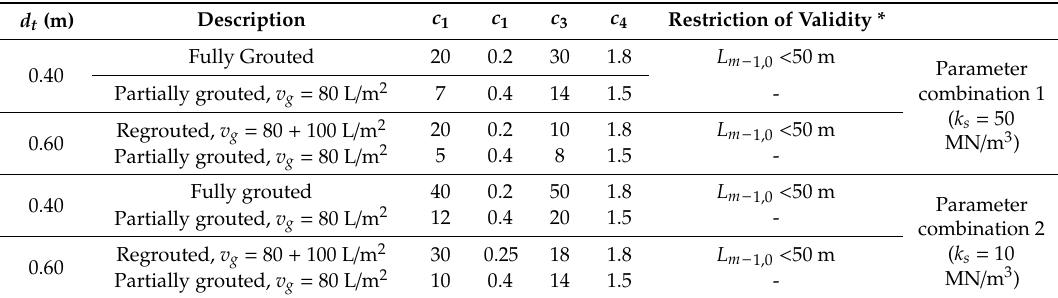
Table 7. Empirical coe ffi cients of the enveloping functions of the maximum relative bending stress for each parameter combination and top layer configuration.